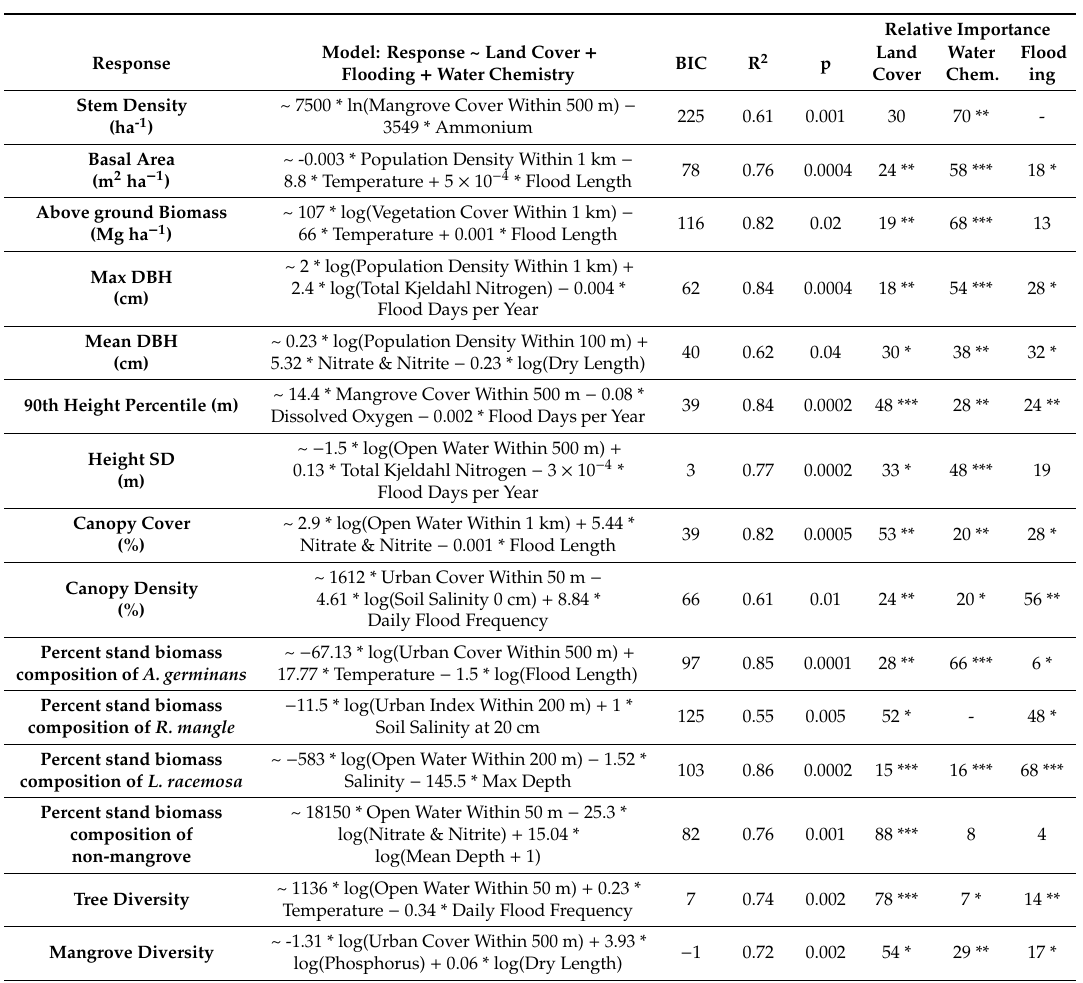
Table 5. Top models for forest structure and composition metrics as determined by the lowest BIC for models containing all possible combinations of surrounding land cover, hydrology, and water quality. Relative importance is the percentage contribution of each variable to the R 2 value. Asterisks are p values of * < 0.05, ** < 0.01 & *** <